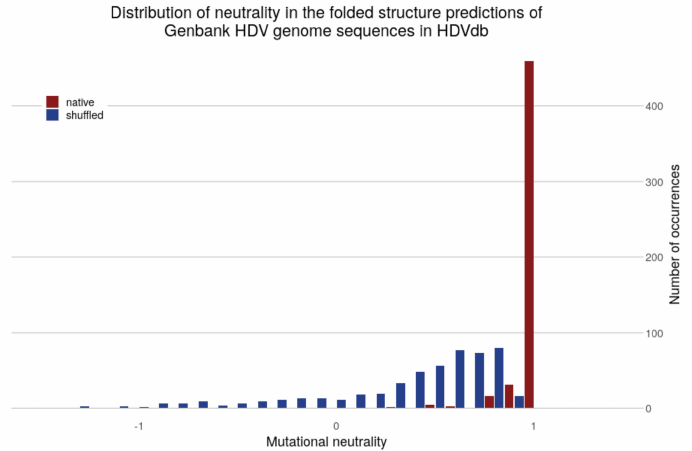
Figure 4. The neutrality distribution of all structures from our dataset comparing native and shuffled sequences. Shuffled sequences with dinucleotide shuffling were obtained using shuffleseq from EMBOSS. Reported p -value (see text) is less than 0.0001.